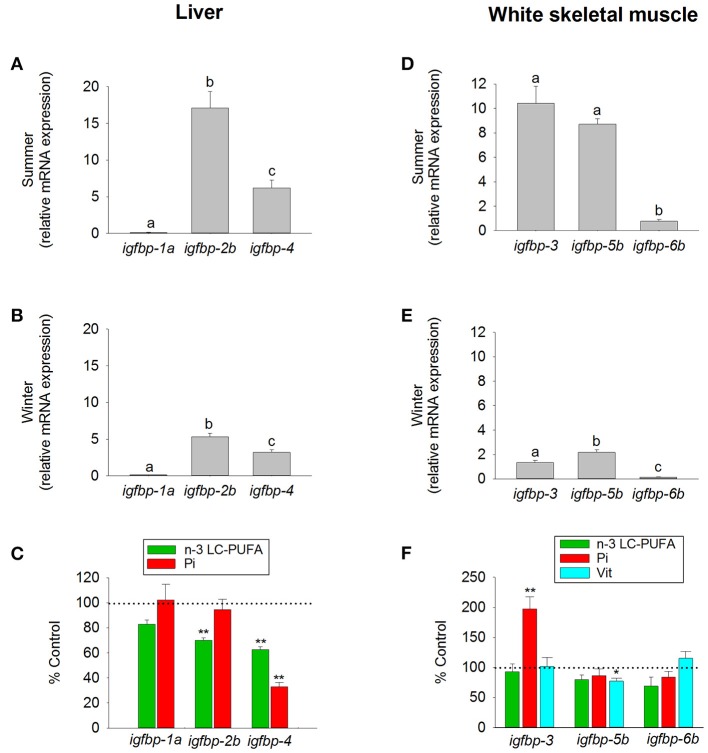
Tissue-specific regulation of igfbp by season and diet in juveniles of gilthead sea bream. Liver expression of igfbp-1a, igfbp-2b, and igfbp-4 (clade igfbp-1/-2/-4) was analyzed in fishes during (A) summer, (B) winter, and (C) after a dietary challenge with a diet deficient in n-3 LC-PUFA (green bars) or phosphorous (Pi, red bars). White skeletal muscle expression of igfbp-3 (primers detected both igfbp-3a and -3b paralogs), igfbp-5b, and igfbp-6b (clade igfbp-3/-5/-6) was analyzed in fishes during (D) summer, (E) winter, and (F) after a dietary challenge with a diet deficient in n-3 LC-PUFA (green bars), phosphorus (Pi, red bars) or vitamins (Vit, cyan bars). RT-qPCR of tissue total RNA was conducted as previously reported (134). Data are represented as the mean ± SEM (n = 6–7). For each tissue and season (A,B,D,E), different superscript letters indicate significant differences (P < 0.05; ANOVA followed by Student-Newman–Keuls test). Asterisks in (C,F) indicate significant differences compared with paralog expression in fishes from group fed a control diet (t-test, *P < 0.05; **P < 0.001). Data derived from samples from Benedito-Palos et al. (146) and Ballester-Lozano et al. (152).